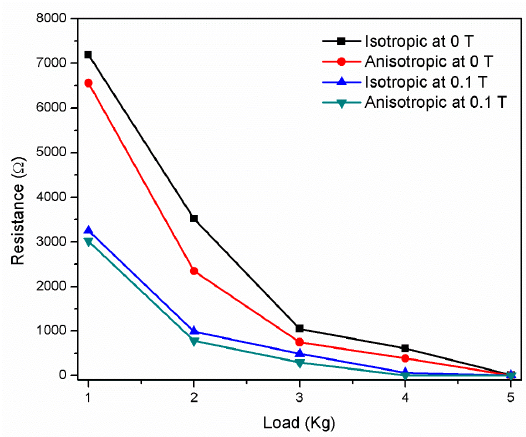
ff -state) and 0.1 T